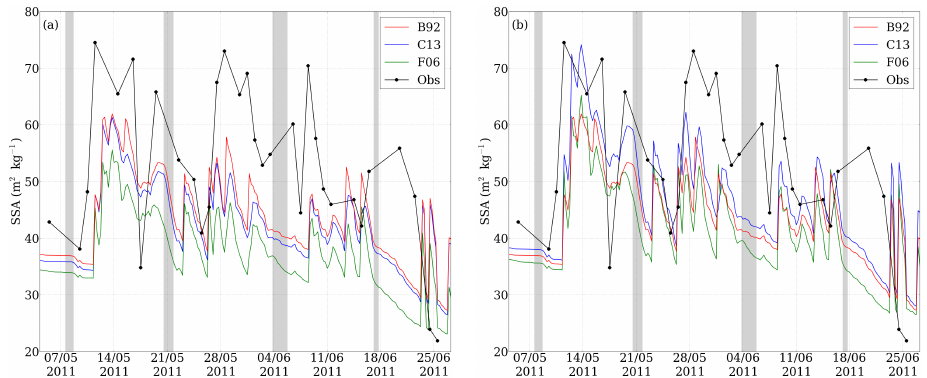
Fig. 9. Time evolution of the SSA of the top 1cm at Summit. The simulated SSA were obtained by making a weighted average of the SSA values within the top 1cm of snow. Grey vertical bands represent periods of strong wind (wind speed > 9ms − 1 ). Formulations C13 and F06 were run setting the maximum SSA value to 65m 2 kg − 1 in (a) and to 80m 2 kg − 1 in (b).